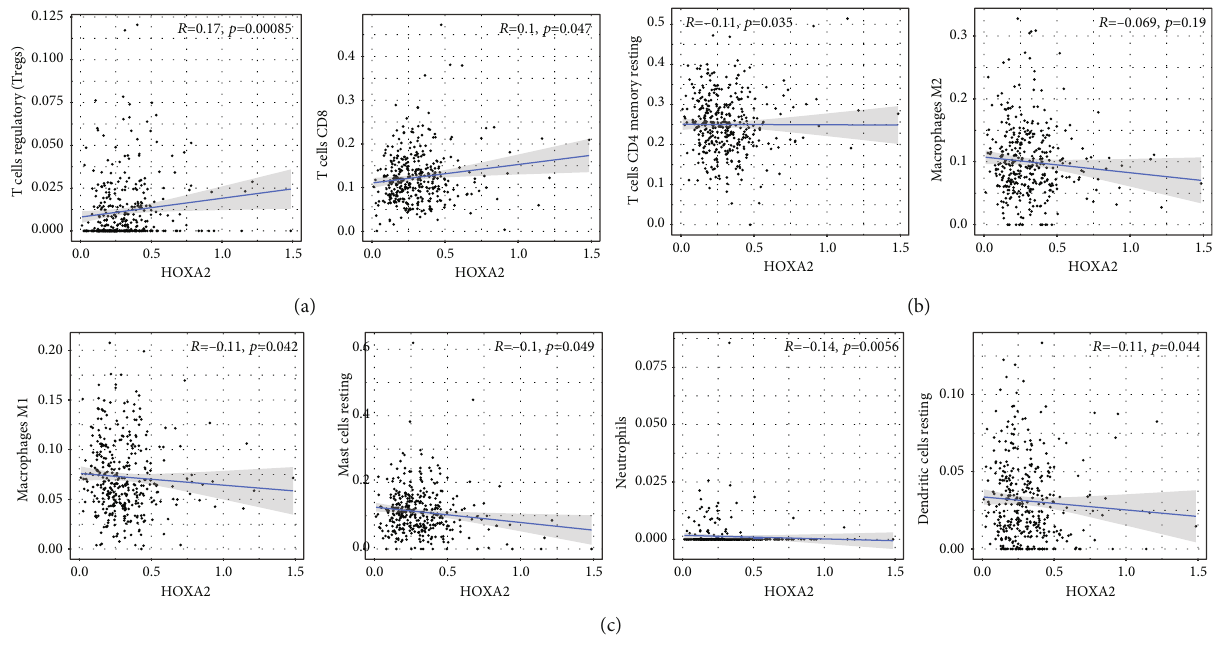
Figure 10: (a – c) Scatter plot presenting the association of 8 types of TIC proportion with the expression of HOXA2.